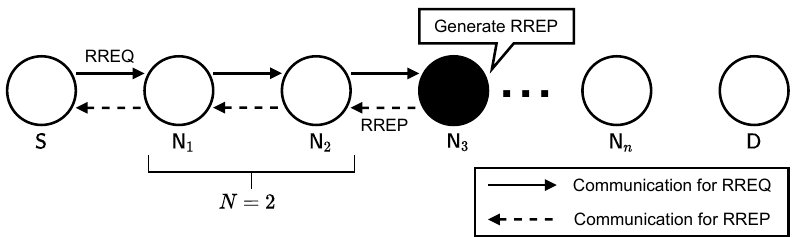
Figure 2. Example of the network configuration for performance evaluation (where N =